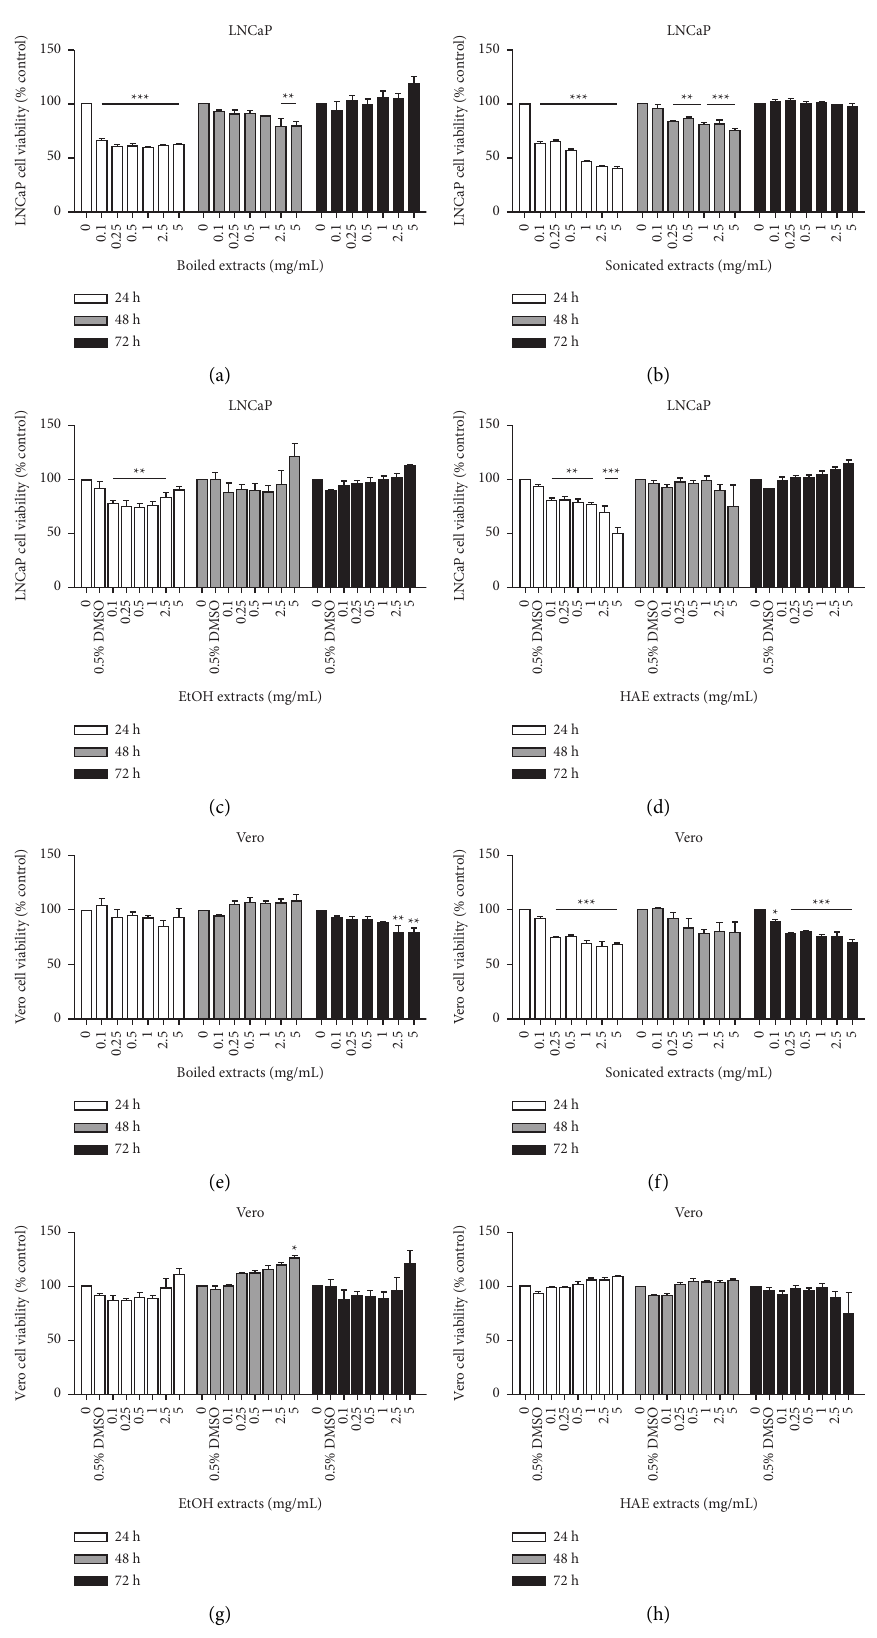
Figure 2: Te antiproliferative efect of various crude extracts from aril parts: (a–d) LNCaP cells; (e–h) Vero cells. (a–h) Cells were cultured in 96-well plates, treated with various concentrations of diferent extracts (0–5 mg/mL), and incubated for 24, 48, and 72h, respectively. Te cell viability of each extract was determined by MTT assay. Data are presented as the means ± SEM ( n � 3) ( p < 0 . 05 ∗ , p < 0 . 01 ∗∗ , and p < 0 . 001 ∗∗∗ were considered signifcant compared to the control) of three independent